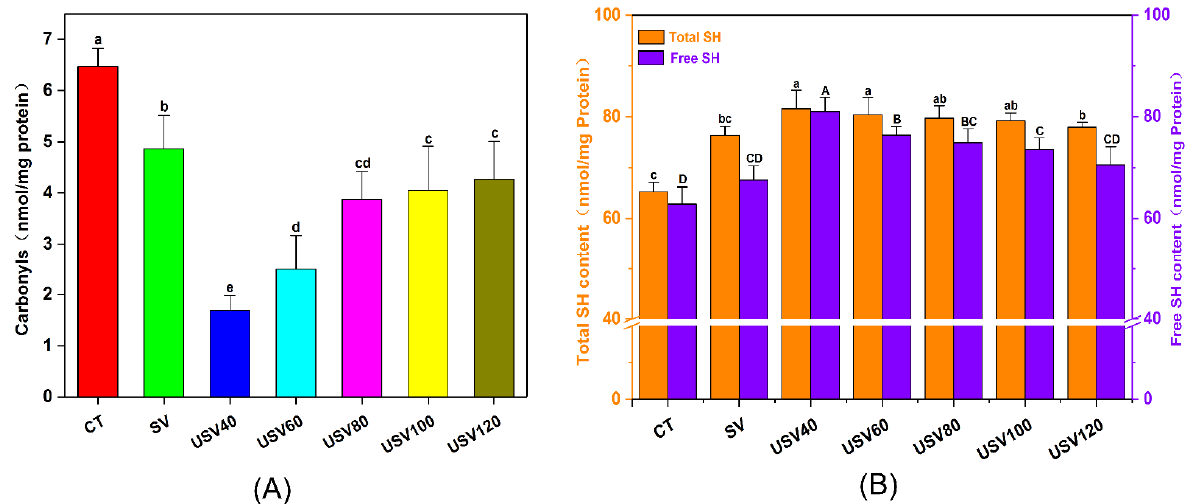
Figure 5. Changes in the carbonyl content ( A ) and sulfhydryl (SH) content ( B ) of spiced beef under different thermal treatments. Different letters (a~d and A~D) indicate a significant difference ( p < 0.05).